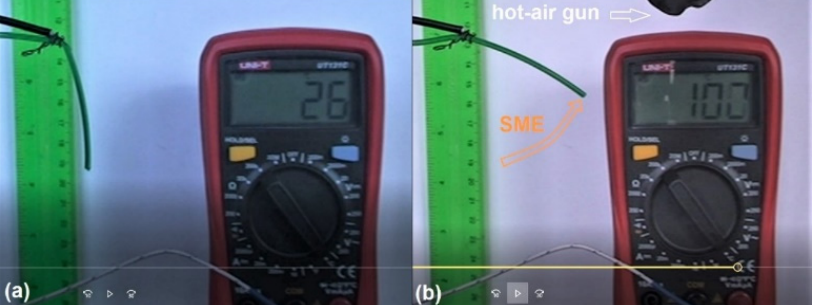
Figure 3. Typical images recorded during the occurrence of free-recovery SME at R-PET filament: ( a ) RT bent cold shape; ( b ) hot shape recovered during 23 s heating.